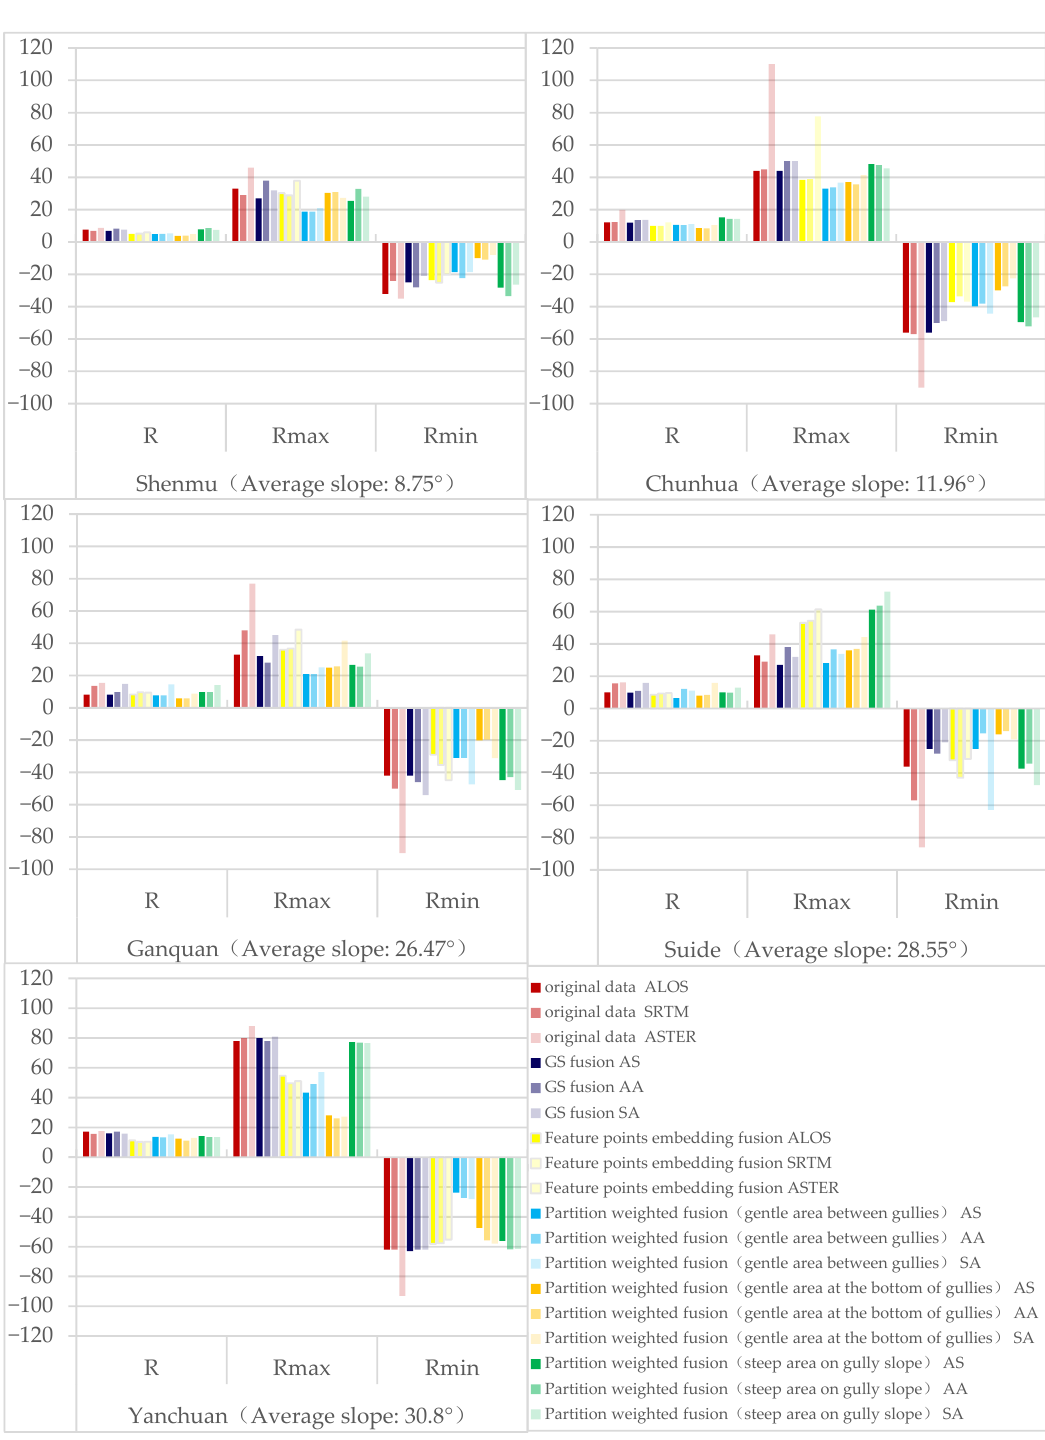
Figure 8 . Error statistics before and after fusion. Figure 8. Error statistics before and after